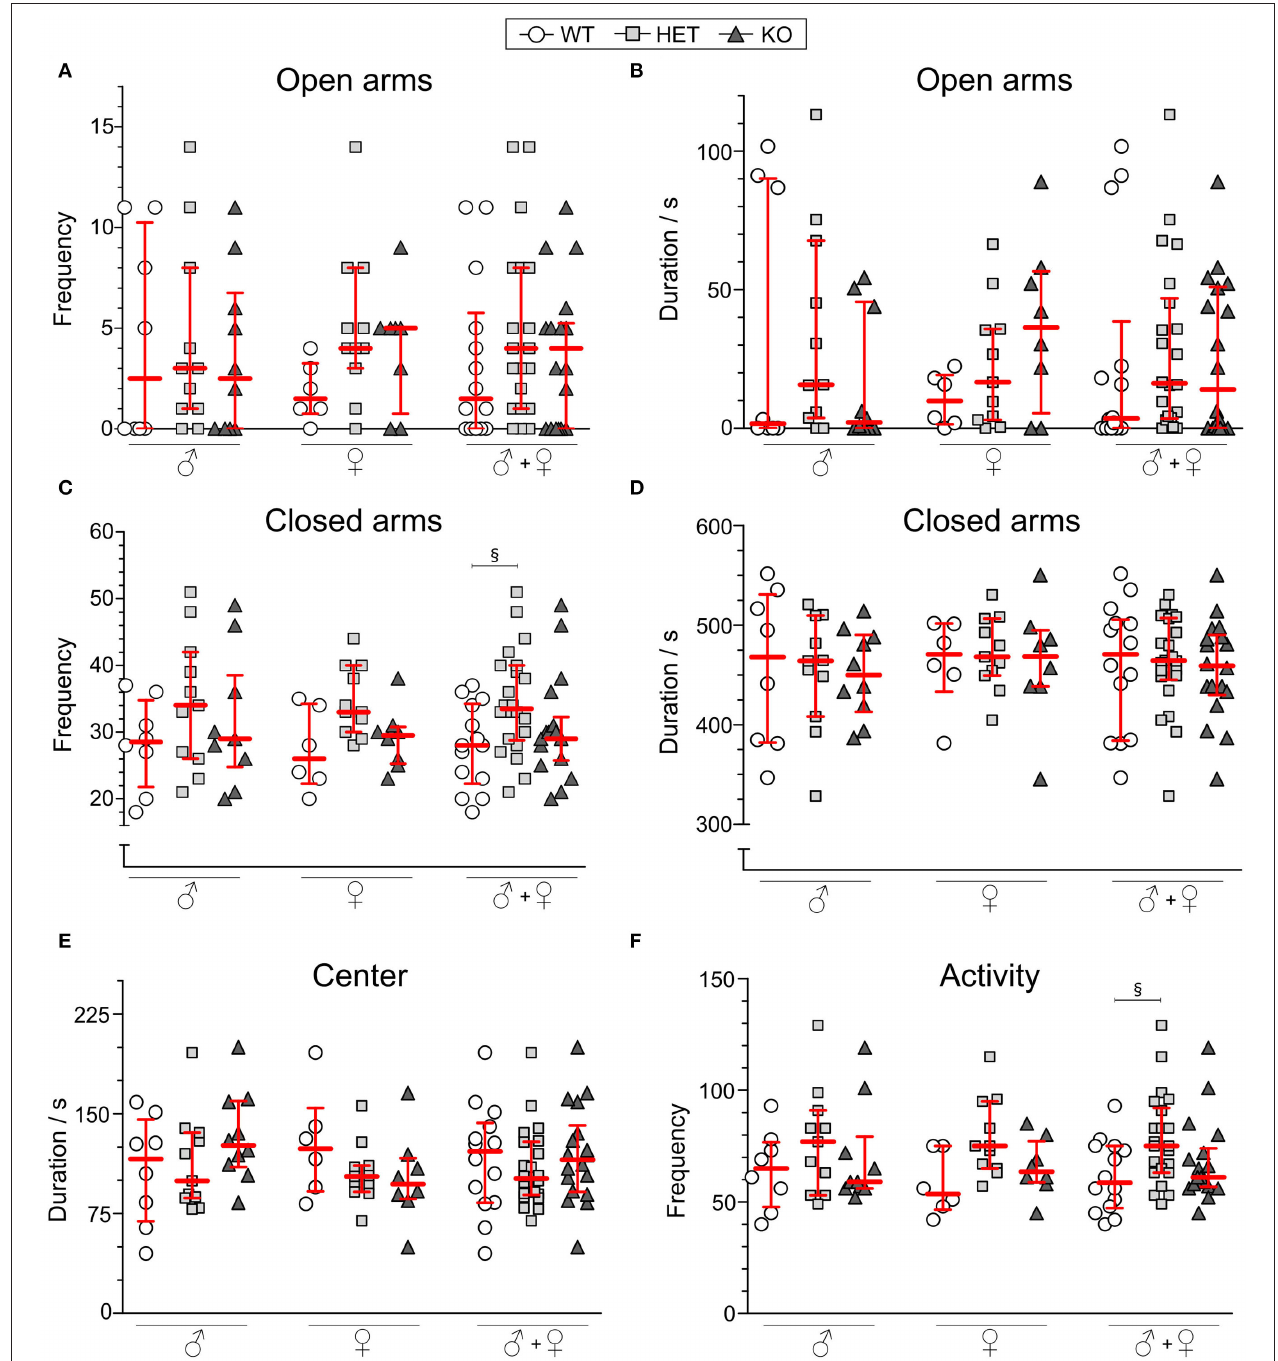
FIGURE 4 | Behavior in the elevated plus maze of SLC38A10-deficient mice. Mice explored the elevated plus maze (EPM) for 10min [ n (males) = 8 WT, 11 HET, 10 KO; n (females) = 6 WT, 11 HET, 8 KO], and (A) frequency and (B) duration in open arms and (C) frequency and (D) duration in closed arms are plotted for each sex separately and together. (E) Duration in center of the EPM is plotted as well for sexes separately and together. As a measure of activity (F) , total frequencies in the arena were analyzed (sum of frequencies in center, open and closed arms). Data are shown as medians with interquartile range. Statistical differences between WT and HET mice are illustrated with the section sign (§). Analyses were made with the Kruskal–Wallis and Dunn’s multiple comparisons test, § p < 0.05.